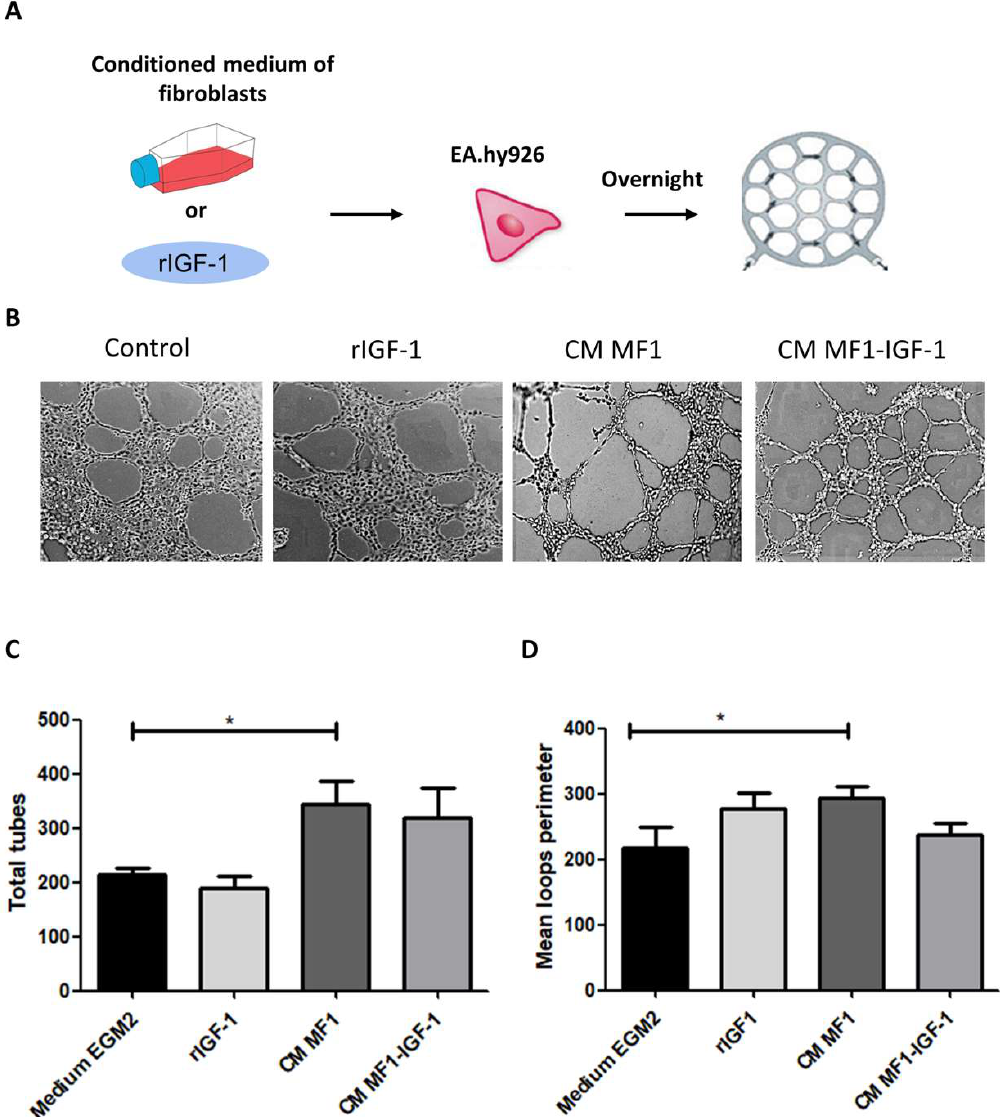
Figure 8. Endothelial tube formation assay. ( A ) Endothelial cells of the EA.hy927 strain were used in the angiogenesis assay, seeded under an artificial matrix (Geltrex) and incubated overnight with di ff erent stimuli (medium, rIGF-1, CM MF1 or CM MF1-IGF-1) as simplified in the scheme. ( B ) Representative images of capillary-like structures formed under each condition. Measurements of the total vessels, Magnification: 400 × . ( C ) and loop perimeter ( D ) formed under di ff erent conditions. Result of six replicates, data presented as means ± SDs, bars represent comparisons between respective groups and (*) denotes statistical significance after applying the one-way ANOVA and Dunnett’s post-test, p < 0.05. CM: conditioned